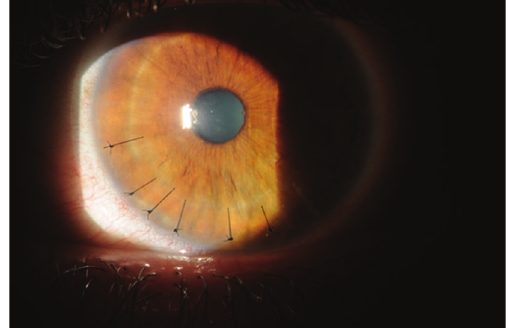
Figure 4: Slit lamp photograph of the injured eye four weeks after surgical correction with all sutures removed with no visible